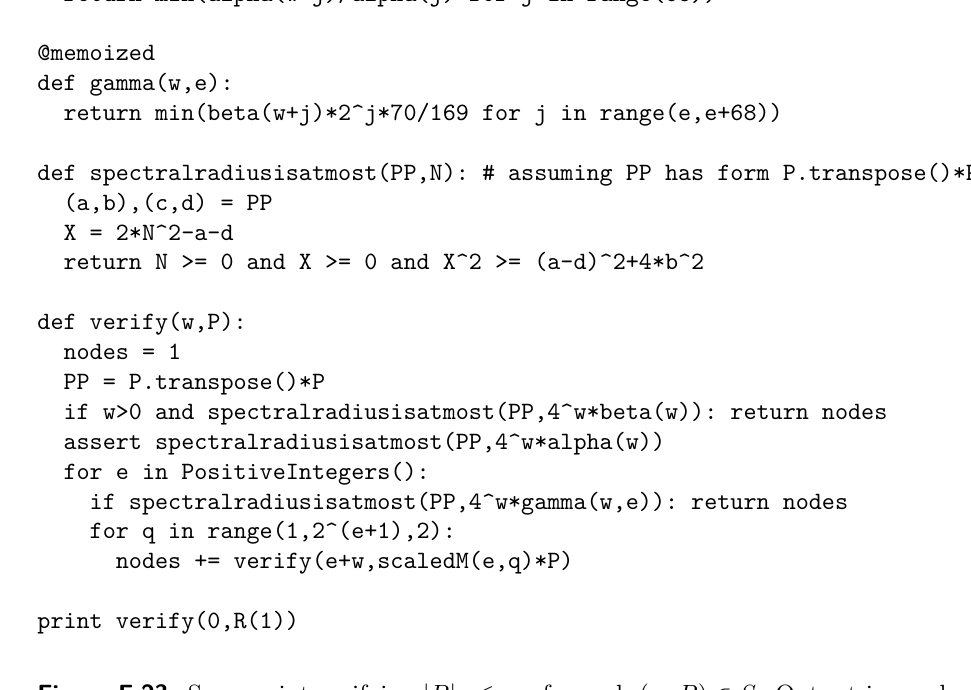
≤ α w for each ( w, P ) ∈ S . Output is number of Figure F.23: Sage script verifying | P | 2 pairs ( w, P ) considered if verification succeeds, or an assertion failure if verification